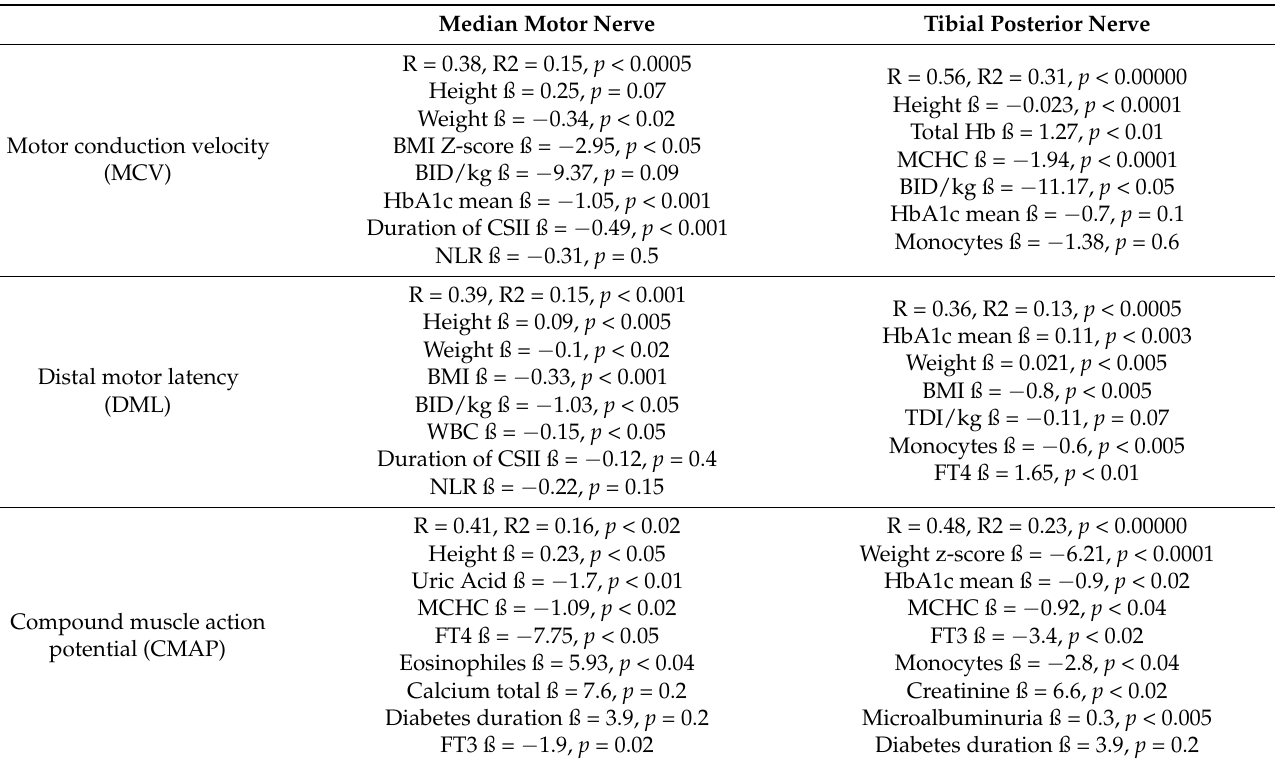
Table 1. Multiple regression models for nerve conduction study parameters nerves.